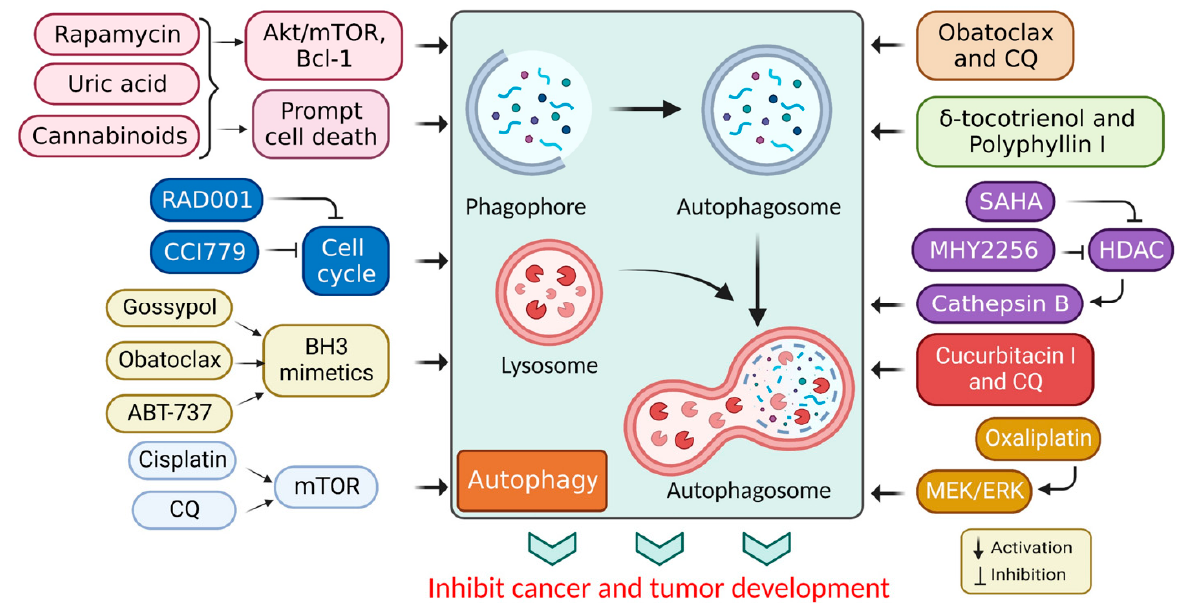
Figure 3. Autophagy stimulation by several compounds and drugs used in cancer therapy.